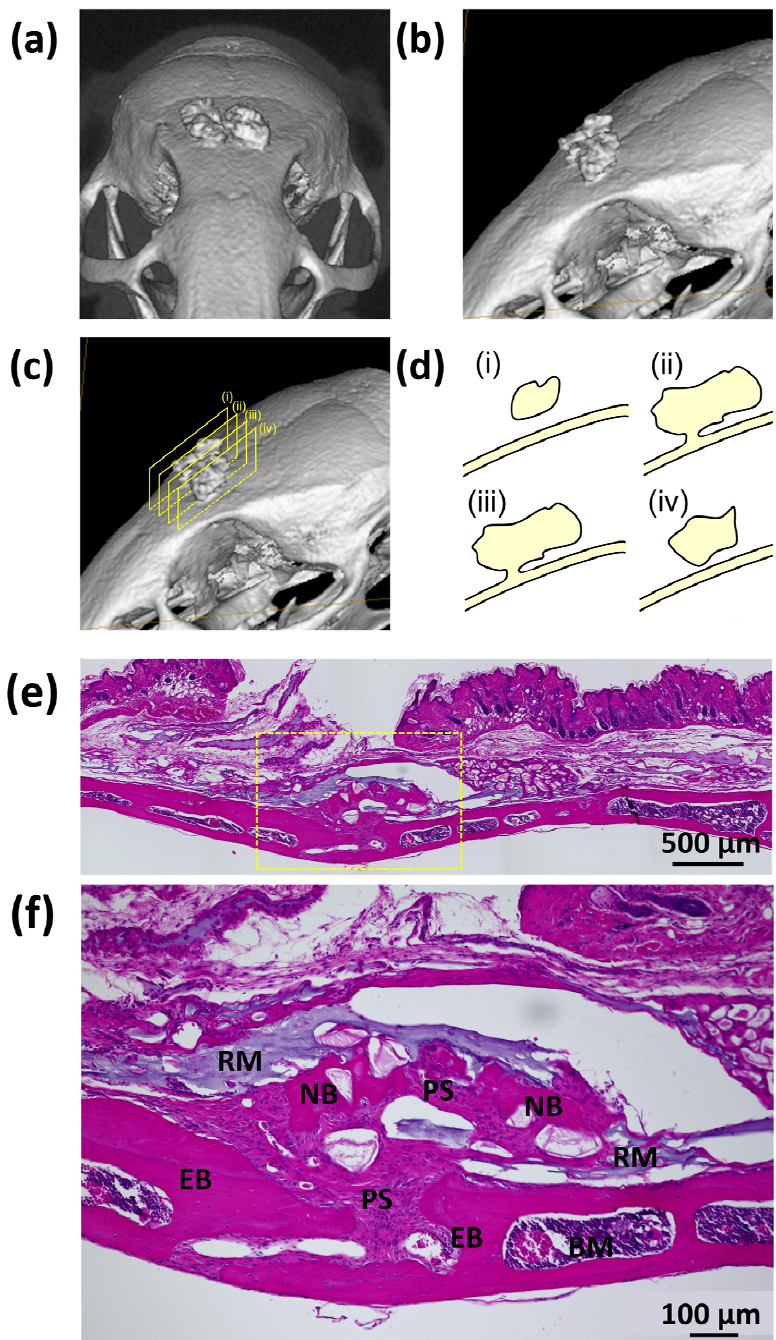
Figure 13. ( a ) Front and ( b ) side micro-CT images of one mouse cranial bone 8 weeks after test SG I (SG I*nHAp (+)) was injected into the cranial connective tissue; ( c ) four sliced rectangles inside the newly formed bone on the cranial existing bone of Figure 13b; ( d ) schematical indication of bone existence states on four slices of Figure 13c; ( e ) the low magnified HE-stained image of the cranial subcutaneous tissue of a mouse 8 weeks after injection of SG I (SG I*nHAp (+)) material; ( f ) the high-magnified HE image of the yellow rectangle area of Figure 13e. Note: RM, residual material; PS, periosteum; NB, new bone; EB, existing bone; BM, bone marrow.